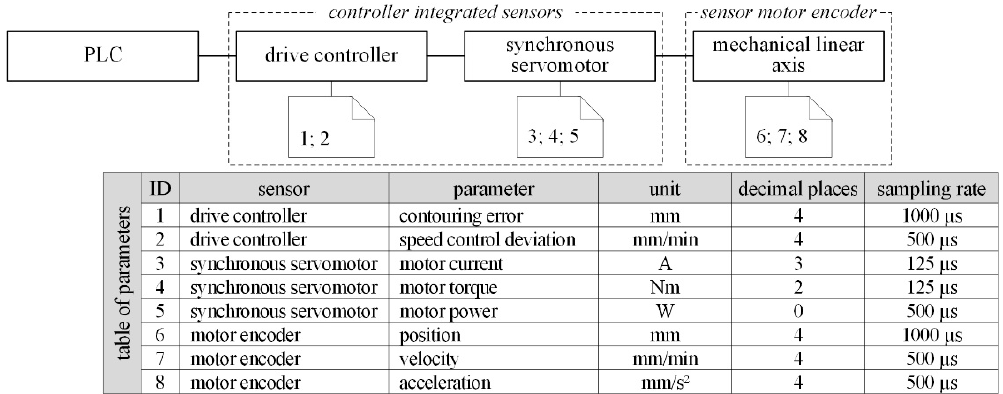
Figure 6. Sensor-nodes and available parameters of the testbed.